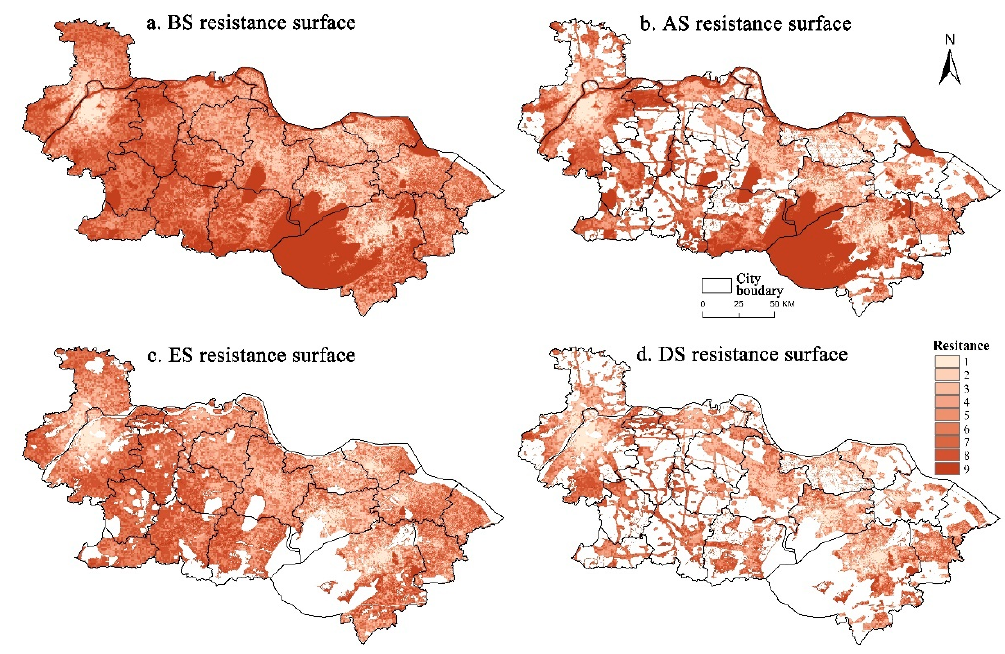
Figure 5. Resistance surfaces of four scenarios. Table 3. Distribution of grids’ resistance value under four scenarios.